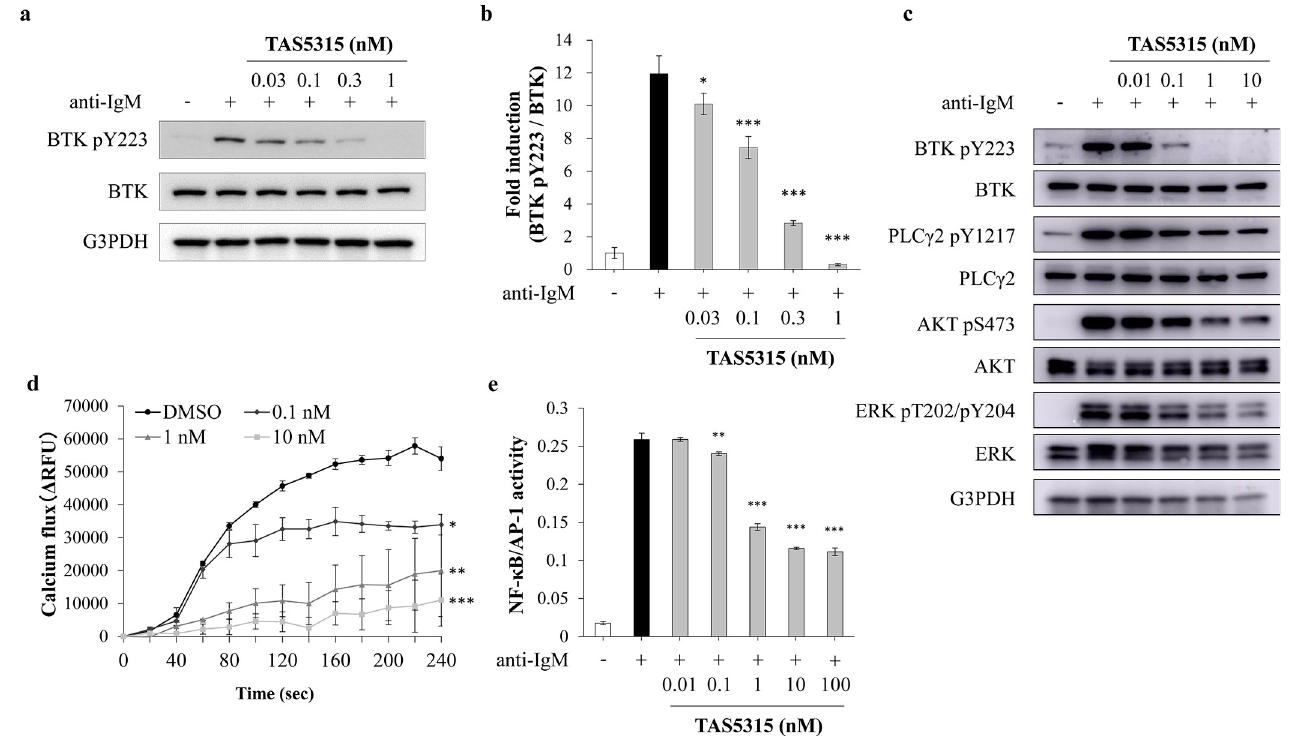
Fig 1. TAS5315 inhibits the phosphorylation of BTK and its downstream signaling pathway in Ramos cells. (a, c) Phosphorylation of various kinases of the BCR signaling pathway induced by anti-IgM stimulation (5 μ g/mL) for 10 min in Ramos cells. TAS5315 was applied for 1 h as pretreatment. Immunoblots provide representative data from three independent experiments. (b) Densitometric analysis of protein amounts to determine the relative levels of phosphorylated BTK compared to that of total BTK. (d) Intracellular calcium flux in Ramos cells induced by anti-IgM stimulation (5 μ g/mL) at the indicated times. TAS5315 was treated for 30 min before anti-IgM stimulation. (e) NF- κ B and AP-1 transcriptional activity in Ramos-Blue cells stimulated with anti-IgM (5 μ g/mL) for 24 h. TAS5315 was treated for 30 min before anti-IgM stimulation. SEAP level (OD value) in the culture supernatant was measured as an index of NF- κ B and AP-1 transcriptional activity. All experiments were performed in triplicate, and the numerical data are presented as mean ± SD. � P < 0.05, �� P < 0.01, ��� P < 0.001 compared with the DMSO group (Dunnett test for TAS5315 groups).